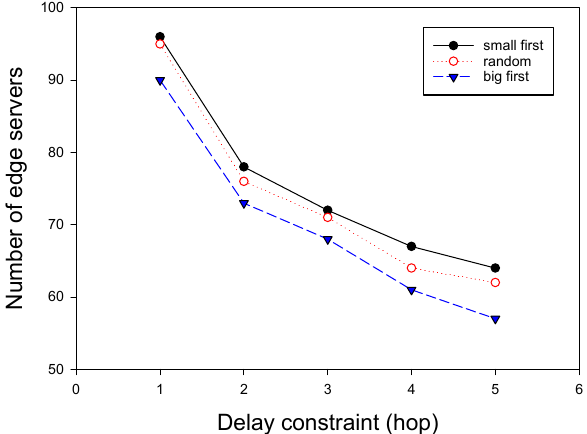
Figure 9. The impact of cluster rebuilding strategy on the number of edge servers.